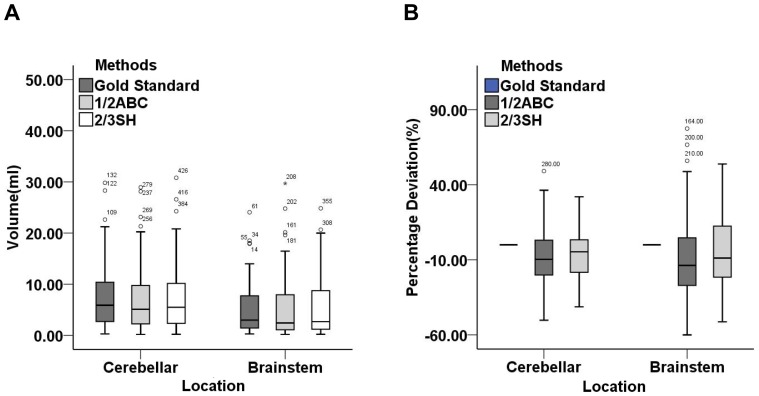
Hematoma volumes (ml) and percentage deviations (%) for cerebellar and brainstem hemorrhages calculated by gold standard, formula 1/2ABC and 2/3SH.(A) the comparison of three methods in hematoma volume was statistically indistinguishable (P>0.05); (B) formula 1/2ABC and 2/3SH underestimated hematoma volume by −10.34(−20.11, 3.10)% and −4.64(18.31, 3.36)% for cerebellar hemorrhage, −13.69(−27.15, 4.78)% and −8.80(−21.74, 13.88)% for brainstem hemorrhage, respectively.